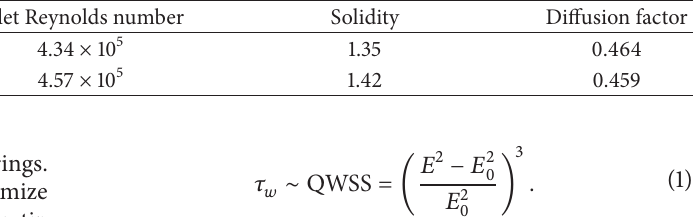
Table 1: Summary of stator flow parameters at peak efficiency loading